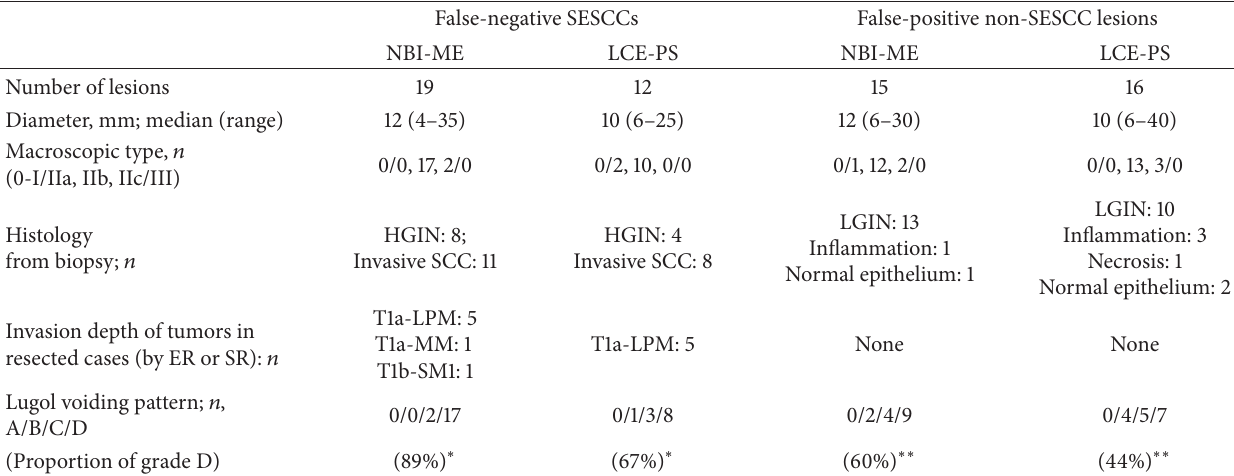
Table 5: Clinicopathological characteristics of misdiagnosed lesions.